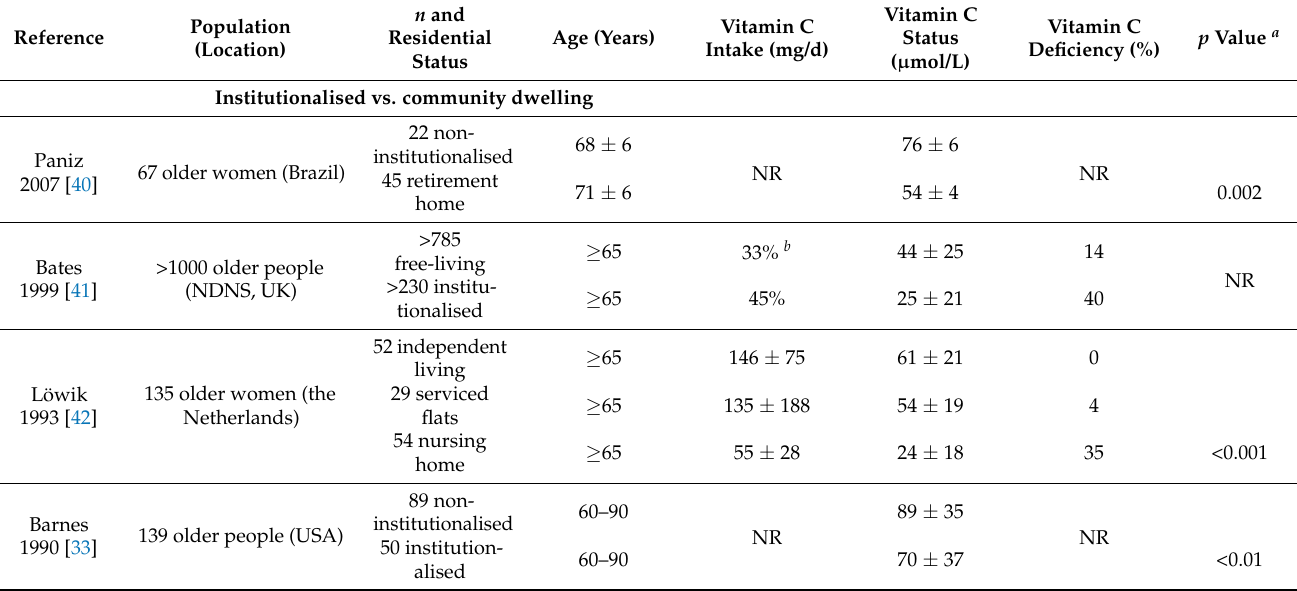
Table 3. Vitamin C status relative to residential